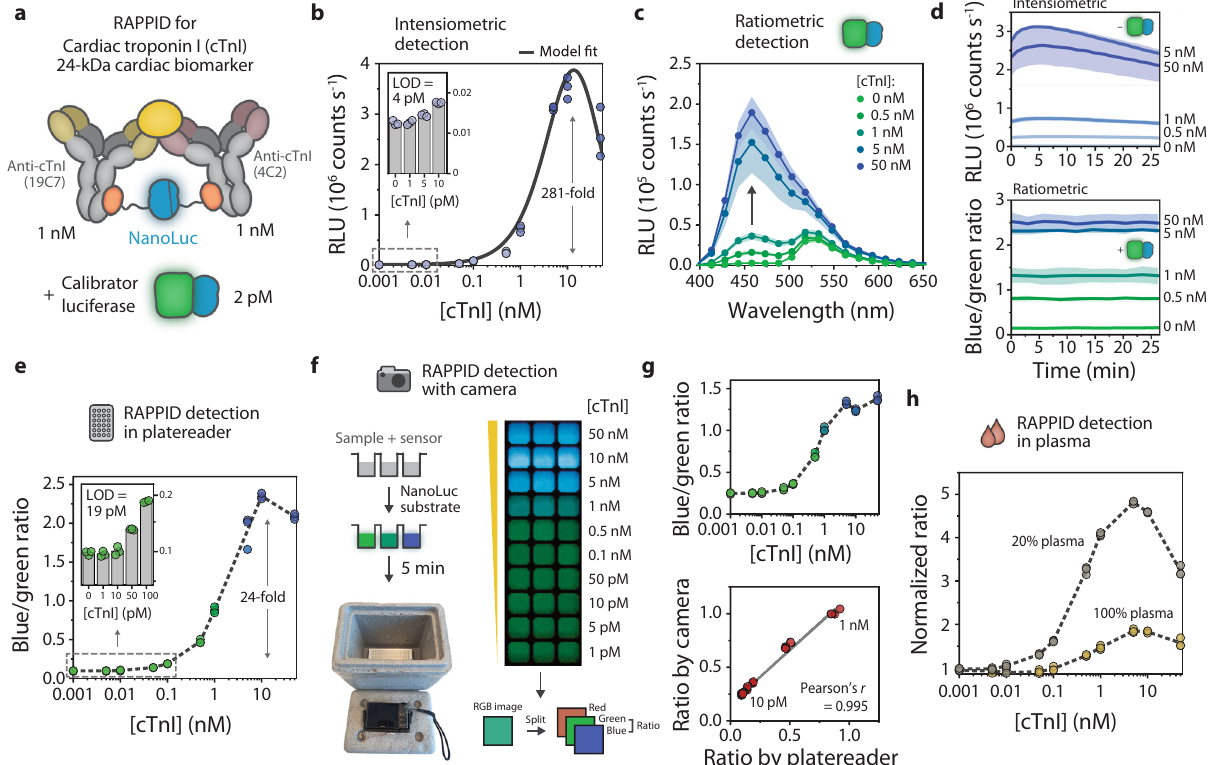
Fig. 2 RAPPID enables robust ratiometric detection of cardiac troponin I (cTnI) in buffer and plasma and allows detection with a digital camera. a Schematic illustration of the sensor components used for the detection of cTnI. All experiments were performed in technical triplicates with independent preparations of the analyte, in buffer (PBS (pH 7.4), 0.1% (w/v) BSA), with 1nM anti-cTnI (19C7) conjugated to Gx-LB, 1nM anti-cTnI (4C2) conjugated to Gx-SB, and 2pM calibrator luciferase, unless indicated otherwise. Reaction mixtures were incubated for 30min at room temperature prior to the addition of NanoLuc substrate and recording of the emission spectra. The blue/green ratio for ratiometric detection was calculated by dividing bioluminescent emission at 458nm by emission at 518 nm. b Intensiometric sensor response curve for cTnI. RLU, relative luminescence units. Inset shows sensor response at low target concentrations. Limit of detection (LOD) was determined at 4.2pM with a maximal fold change of 281. An overview of all sensor characteristics including LOD con fi dence intervals and Z ′ -factor statistical coef fi cients can be found in Supplementary Table 2. Experimental data were fi tted to a thermodynamic model (solid line, see Supplementary Fig. 4). c Bioluminescence spectra at various concentrations of cTnI in the presence of 2pM calibrator luciferase. d Sensor output over time for the experiments described in ( b ) (top, intensiometric) and ( c ) (bottom, ratiometric). Data in ( c ) and ( d ) are represented as mean ±sd. of technical triplicates, with n = 3 independent preparations of the analyte. e Sensor response curve for increasing concentrations of cTnI. Blue/green ratios were calculated from the spectra in ( c ), and show a 24-fold maximal increase in signal. The inset displays sensor behavior in the low-concentration regime as indicated by the dashed rectangle, with a limit of detection (LOD) of 19pM. f Bioluminescent emission does not require external excitation and therefore enables detection with a conventional digital camera (Sony DSC-RX100) inside a box (left bottom). Photograph of the sensor response for increasing cTnI concentration (right), taken 5min after addition of the NanoLuc substrate. g Response curve calculated from the photograph in ( f ) (top) and the correlation between results from the plate reader and digital camera (bottom) for cTnI concentrations below 1nM. A solid line indicates linear fi t. Correlation analysis yielded a Pearson correlation coef fi cient ( r ) = 0.996. h Sensor response in 100% (yellow) and 20% (gray, diluted in buffer) human blood plasma, recorded in the plate reader. In ( b ), ( e ), ( g ), ( h ) individual data points are represented as circles, bars represent mean values, and dashed lines connect mean values. Data represent technical replicates, with n = 3 independent preparations of the analyte. Source data are provided as a Source Data fi